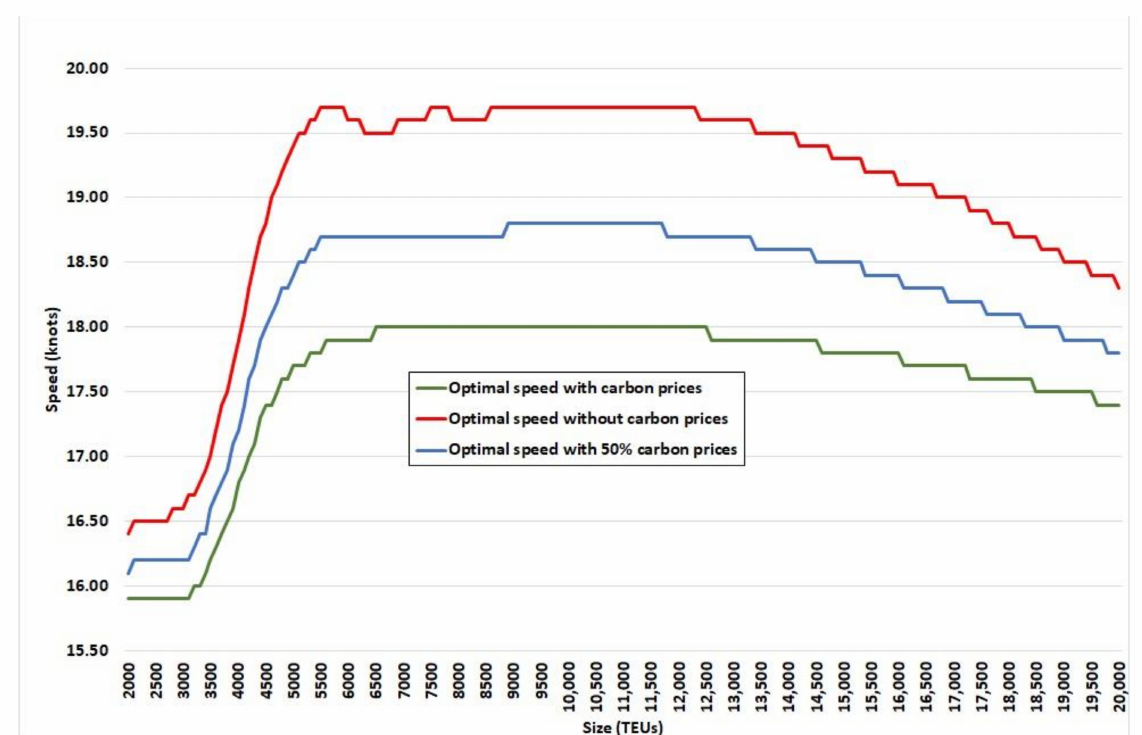
Figure 10. Variable margin as a function of size (TEUs) and speed (knots) with CO 2 allowance prices.